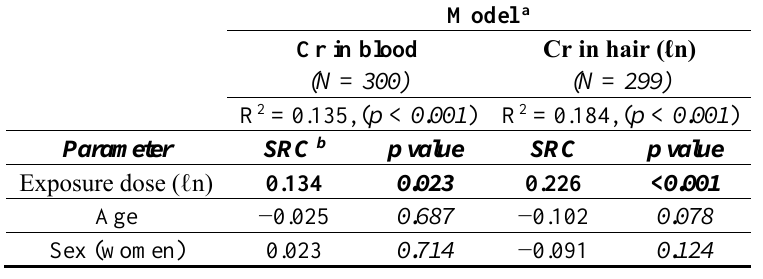
Table 3. Association between exposure dose and chromium levels in hair or in